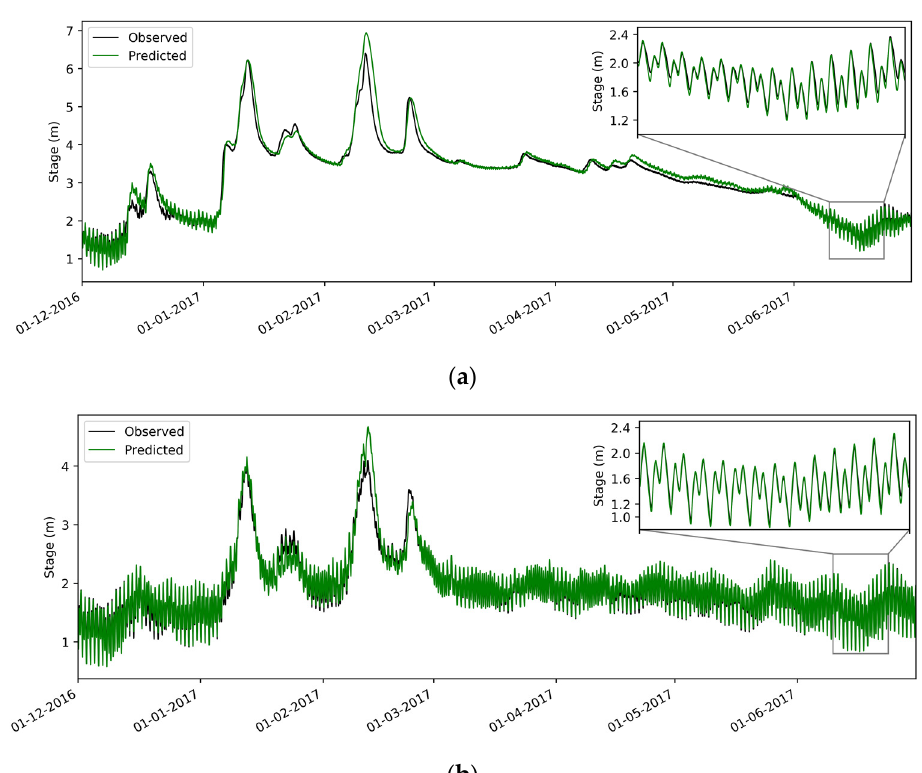
Figure 4. Calibration plot for the BEN ( a ), and SMR ( b ) gages (Table 1) showing the observed (black) and modeled (green) water surface elevation for the period simulated. The inset shows the comparison of observed versus modeled during a tidally dominated period.